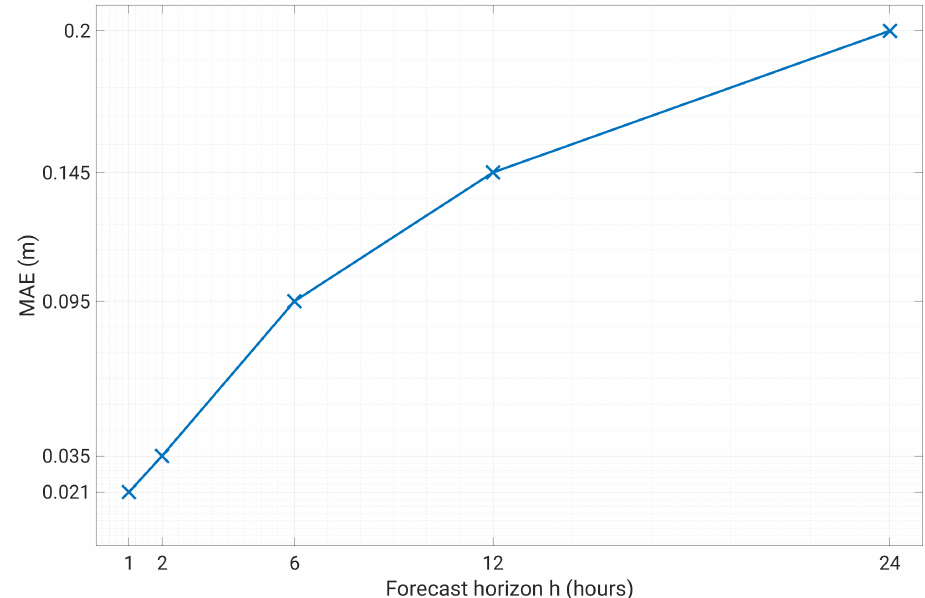
Figure 15. Prediction error as a function of the forecast